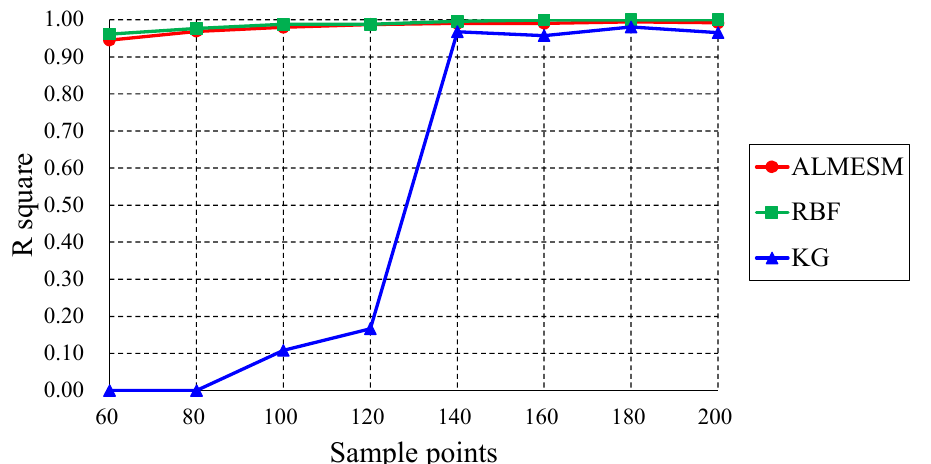
Figure 8. R-squared comparison of ALMESM, RBF, and KG under different number of sample points